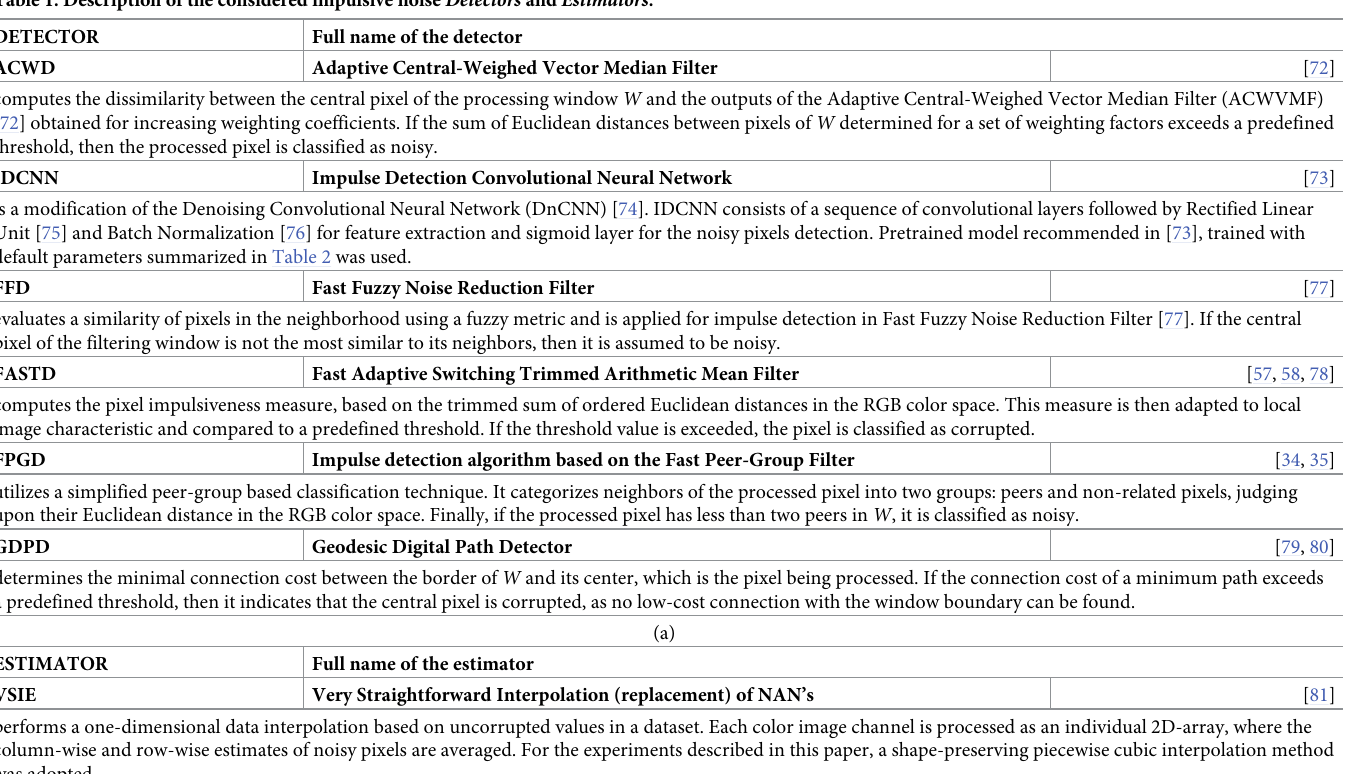
Table 1. Description of the considered impulsive noise Detectors and Estimators